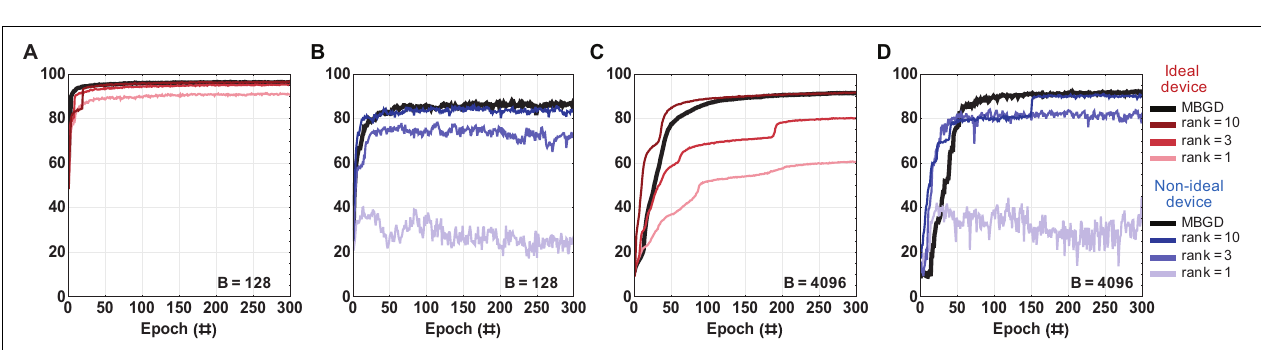
FIGURE 7 | The rank-seq streaming batch PCA results for a multi-layer perceptron with ideal vs. non-ideal memristive weights at different ranks and batch sizes. (A,B) Convergence curves using the rank-seq weight transfer method at batch size = 128; and similarly (C,D) at batch size = 4096. The results show that the streaming batch PCA using rank-seq transfer method cannot approximate the MBGD results, even at high ranks. For all these experiments, the rounding method is stochastic and block size = 32.